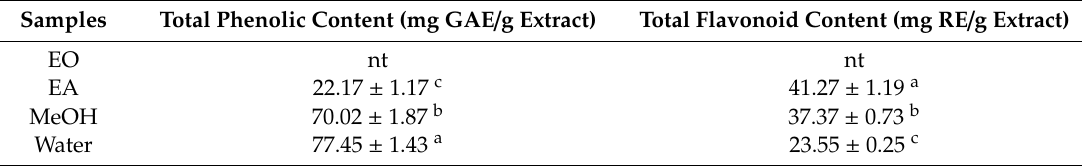
Table 2. Total bioactive components of the tested